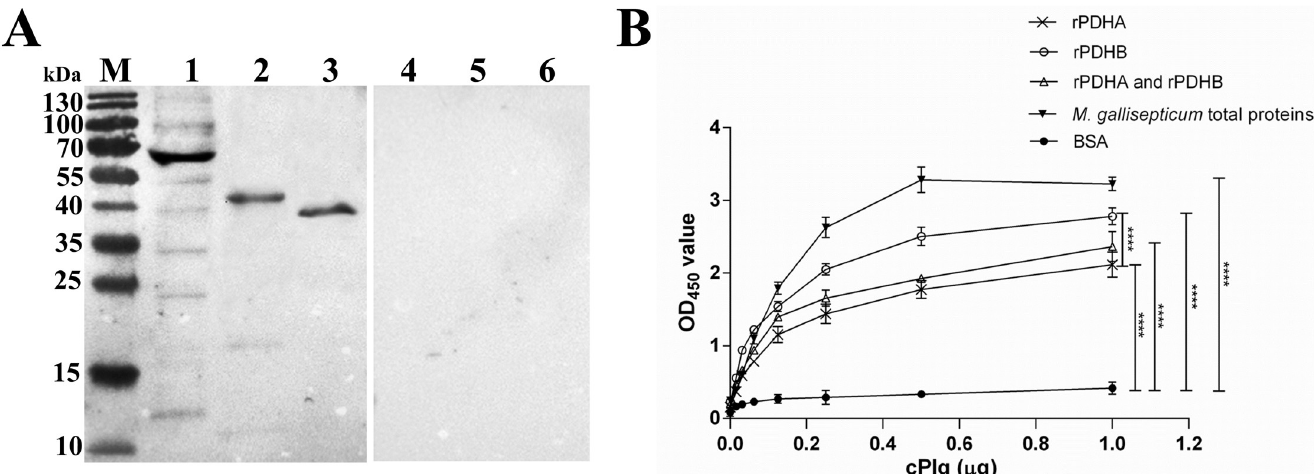
Fig 6. Binding assays of rPDHA or rPDHB with cPlg. (A) Binding assays by Western blot using rabbit polyclonal antibody against cPlg. The total M . gallisepticum protein (lane 1), purified rPDHA (42 kDa; lanes 2 and 5) and rPDHB (38 kDa; lanes 3 and 6) incubated with 10 μ g/mL cPlg and rabbit anti-cPlg (lanes 1, 2 and 3) or rabbit anti-cPlg alone (lanes 4, 5 and 6, negative control). Both rPDHA and rPDHB bound cPlg (lanes 2 and 3), but neither bound rabbit anti-cPlg (lanes 5 and 6). (B) Binding assay by ELISA. ELISA plates were coated with purified rPDHA or rPDHB at 1 μ g per well, or a mixture of rPDHA and rPDHB at 0.5 μ g per well each, incubated with serially diluted cPlg (0, 0.015, 0.03, 0.06, 0.125, 0.25, 0.5 or 1.0 μ g per well) and probed with rabbit polyclonal antibody against cPlg. Plates coated with M . gallisepticum total proteins or BSA (1 μ g per well) were positive and negative controls. Statistical analyses were by two-way ANOVA in GraphPad Prism version 6 ( ���� , p < 0.0001).